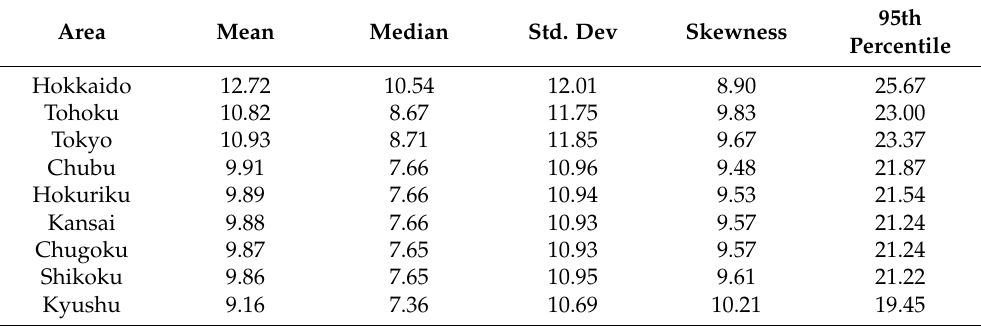
Table 1. Summary statistics of area prices (JPY/kWh) in the JEPX for the period 1 April 2016 to 31 March 2022.